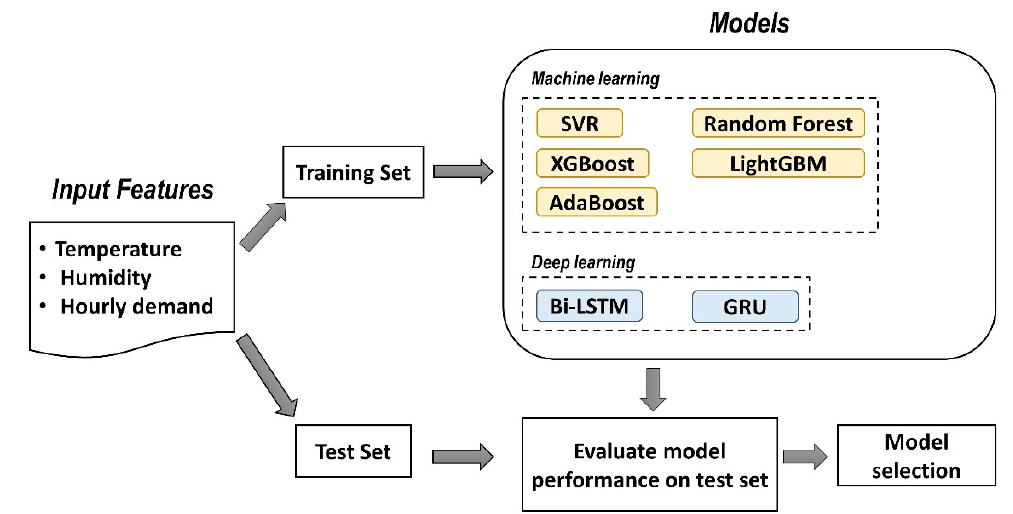
Figure 1. Experiment for Short-Term Electricity Demand Forecasting. These are the descriptions of the different methods utilized in the